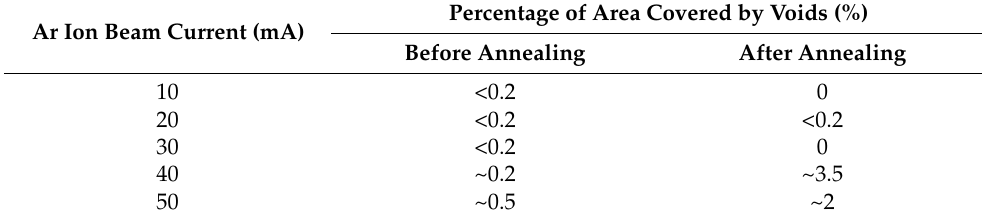
Figure 2. SAM images of the bonded Si-Si specimens activated under the Ar ion beam currents of ( a ) 10 mA, ( b ) 20 mA, ( c ) 30 mA, ( d ) 40 mA and ( e ) 50 mA, respectively, and having undergone the post-annealing treatment. Table 1. Percentages of area covered by voids of the bonded Si-Si specimens before and after annealing